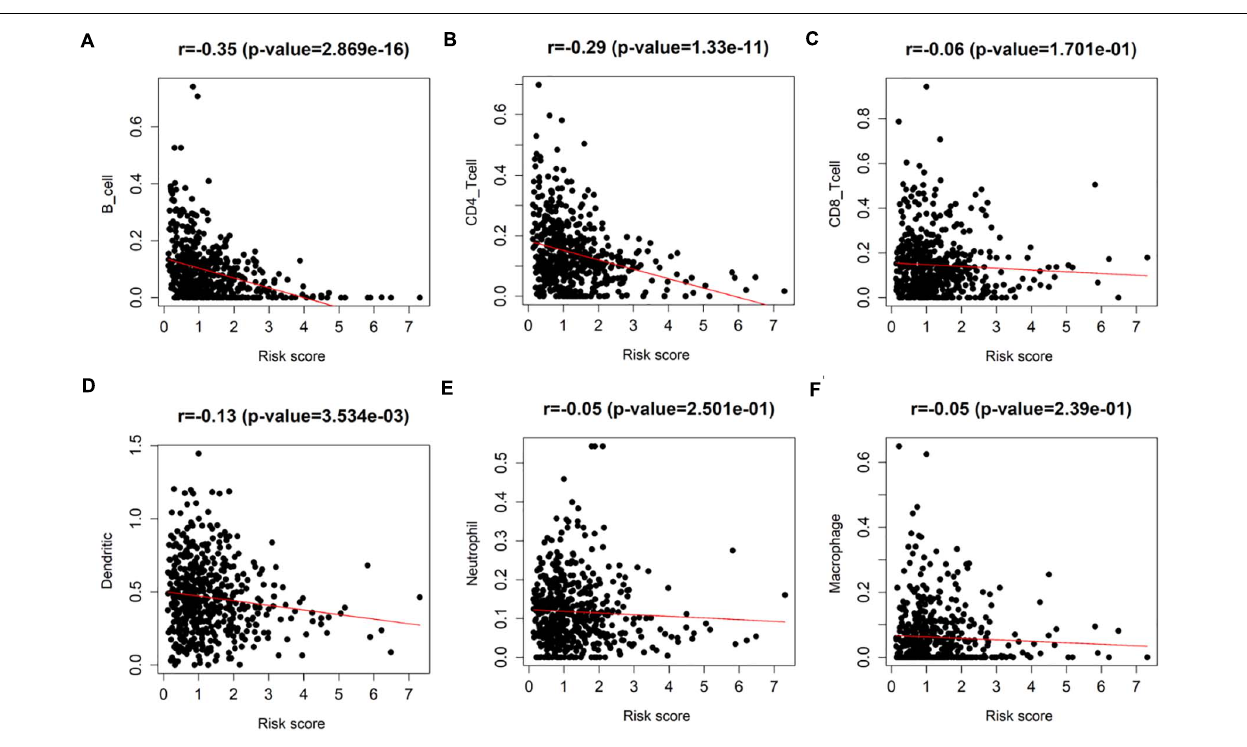
FIGURE 7 | Detection of the correlation between the eight-immune-related-lncRNA prognostic signature and each immune cell subgroup. Pearson correlation analysis was undertaken to detect the correlation between the risk score of LUAD patients predicted by the model and the infiltration of (A) immune B cells, (B) CD4+ T cells, (C) CD8+ T cells, (D) dendritic cells, (E) neutrophils, and (F) macrophages in patient’s cancer